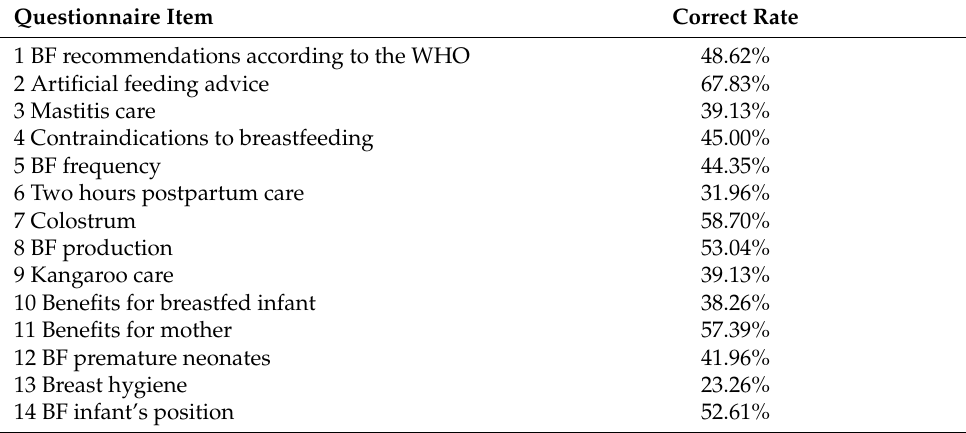
Table 2. Questionnaire item correct rate.